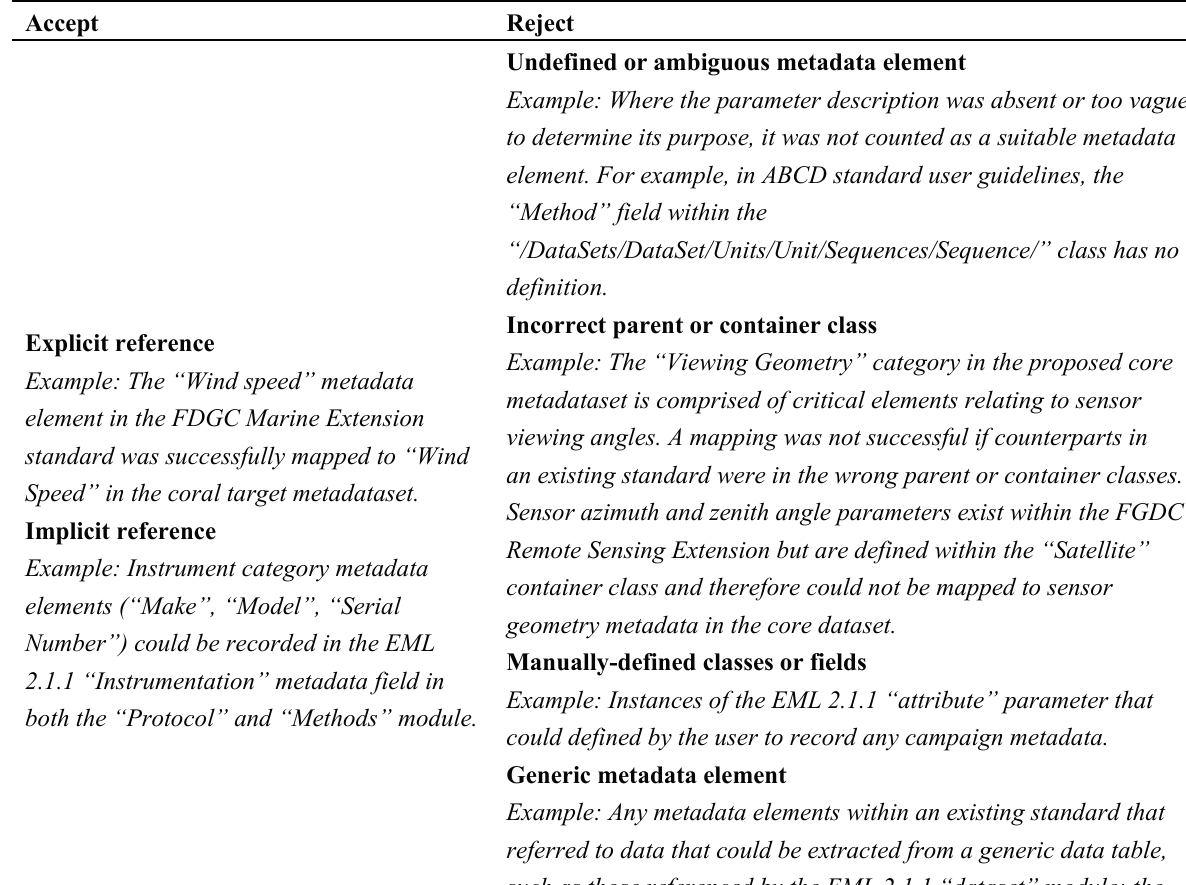
Table 3. Criteria for accepting or rejecting a metadata element in an existing standard for